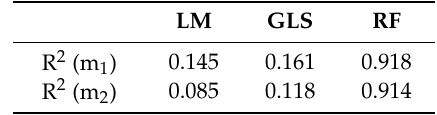
Table 5. Coefficients of determination for the best-fit model parameters in comparing the estimation techniques linear model (LM), the extended linear model with no random effects (GLS), and the random forest (RF).